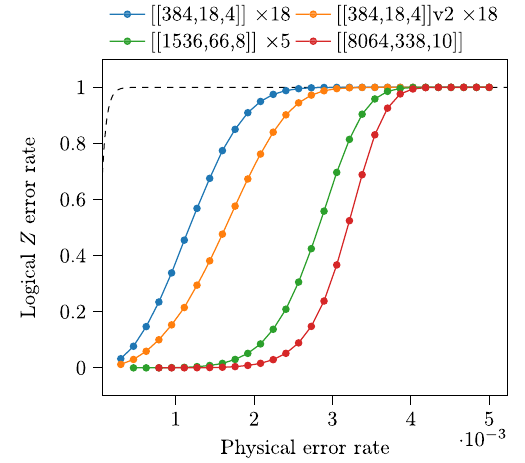
FIG. 17. Performance of the extremal l ¼ 2 f 8 ; 4 g subsystem semihyperbolic codes under a circuit-level depolarizing noise model. Here, we fix the number of logical qubits to at least 338 for all codes by using multiple copies of the smaller codes. A homogeneous ð ZX Þ 20 schedule is used for all codes, and the y axis is the probability that at least one logical Z error occurs. The dashed black line is the probability of a Z error occurring on at least one of 338 physical qubits without error correction under the same error model for the same duration (80 time steps). For each code that encodes k < 338 logical qubits, we use m ¼ b k= 338 c copies and plot the failure rate as p (cid:3) ¼ 1 − ð 1 − p log Þ m . log